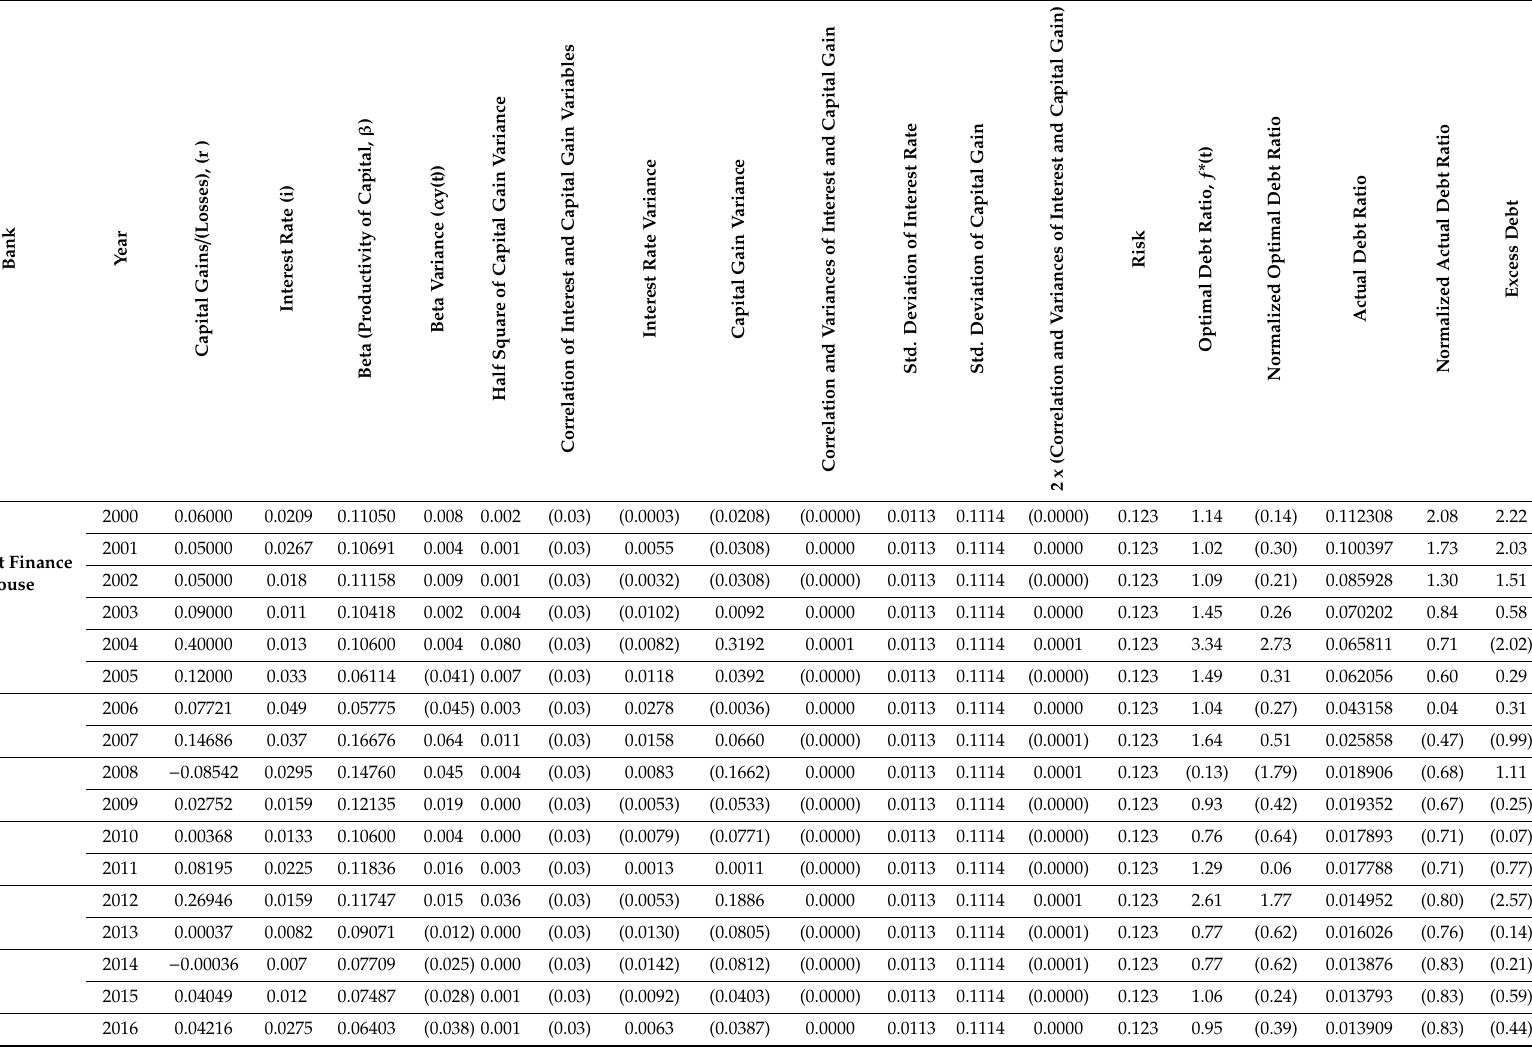
Table A9. Calculations of Optimal and Excess Debt: Kuwait Finance